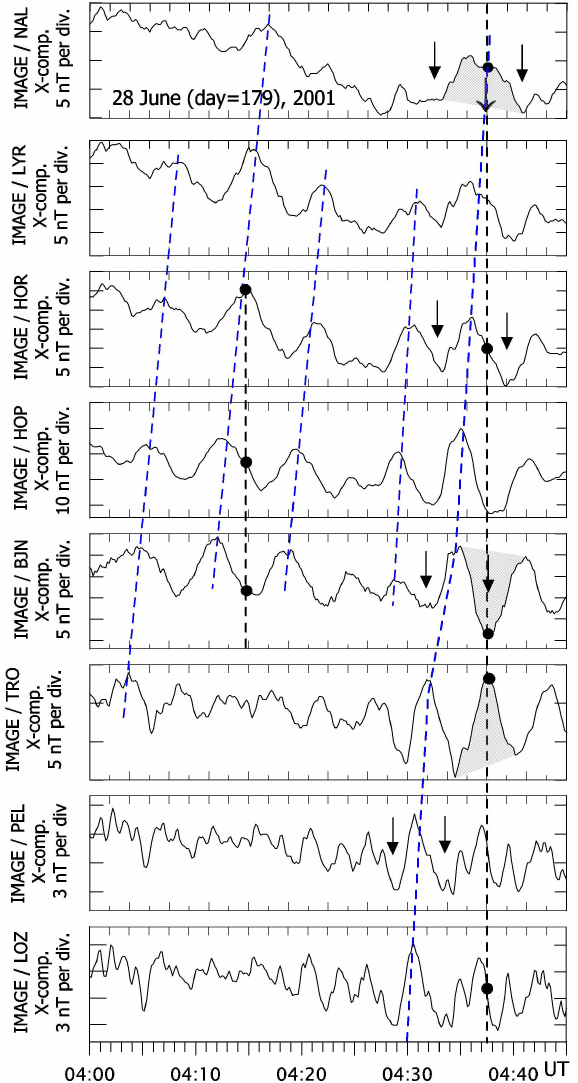
Fig. 3. A stack of eight X component magnetograms from the IMAGE array concerning the event of day 179, 2001. The slant- dashed lines emphasize the dispersive character in signature arrival times. In particular, we pay attention to the double phase change of 180 ◦ which occurred at ∼ 04:37